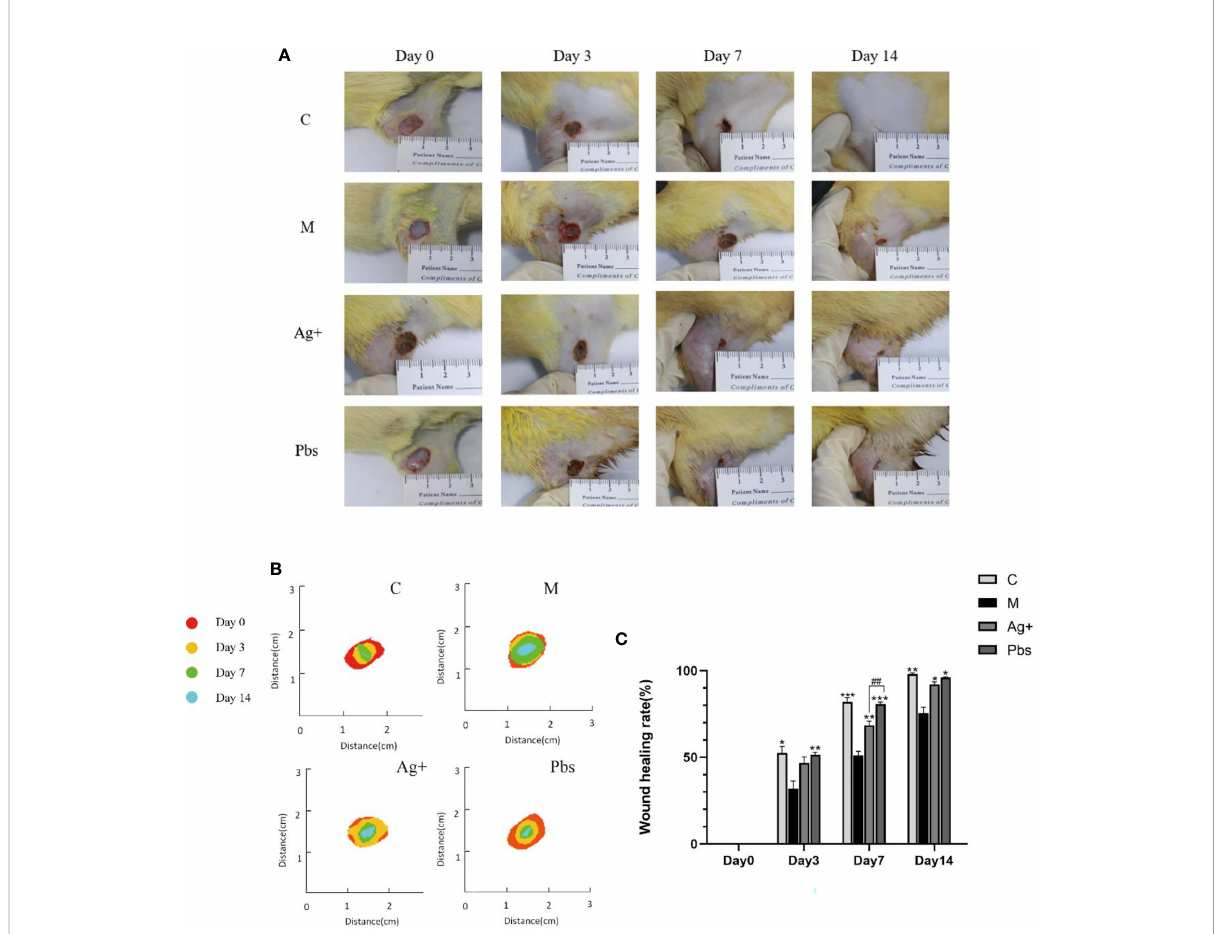
FIGURE 1 The effects of wound healing by puffball spore treatment in diabetic rats. (A) The wound areas were recorded by a camera on days 0, 3, 7, and 14. (B) Heat map of the wound healed by different treatments over 14 days. (C) Quantitative data of relative wound area at different time points.(Means ± SEM, n = 7; *P < 0.05, **P < 0.01, ***P < 0.001 vs. Model group, ##P < 0.01 vs. positive group.).